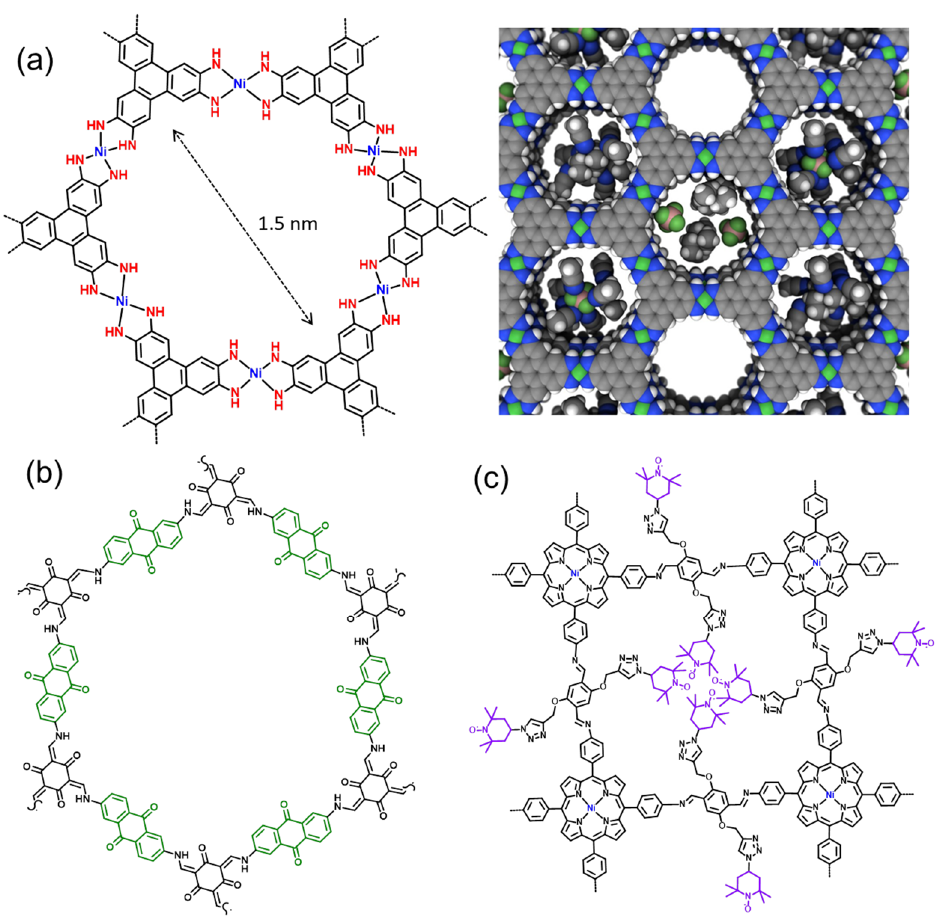
Figure 3. Chemical structure of ( a ) Ni-based two-dimensional MOF structures having the C 3 -symmetric hexaminotriphenylene units [58], ( b ) anthraquinone [62], and ( c ) TEMPO [63] moieties containing COF structures.